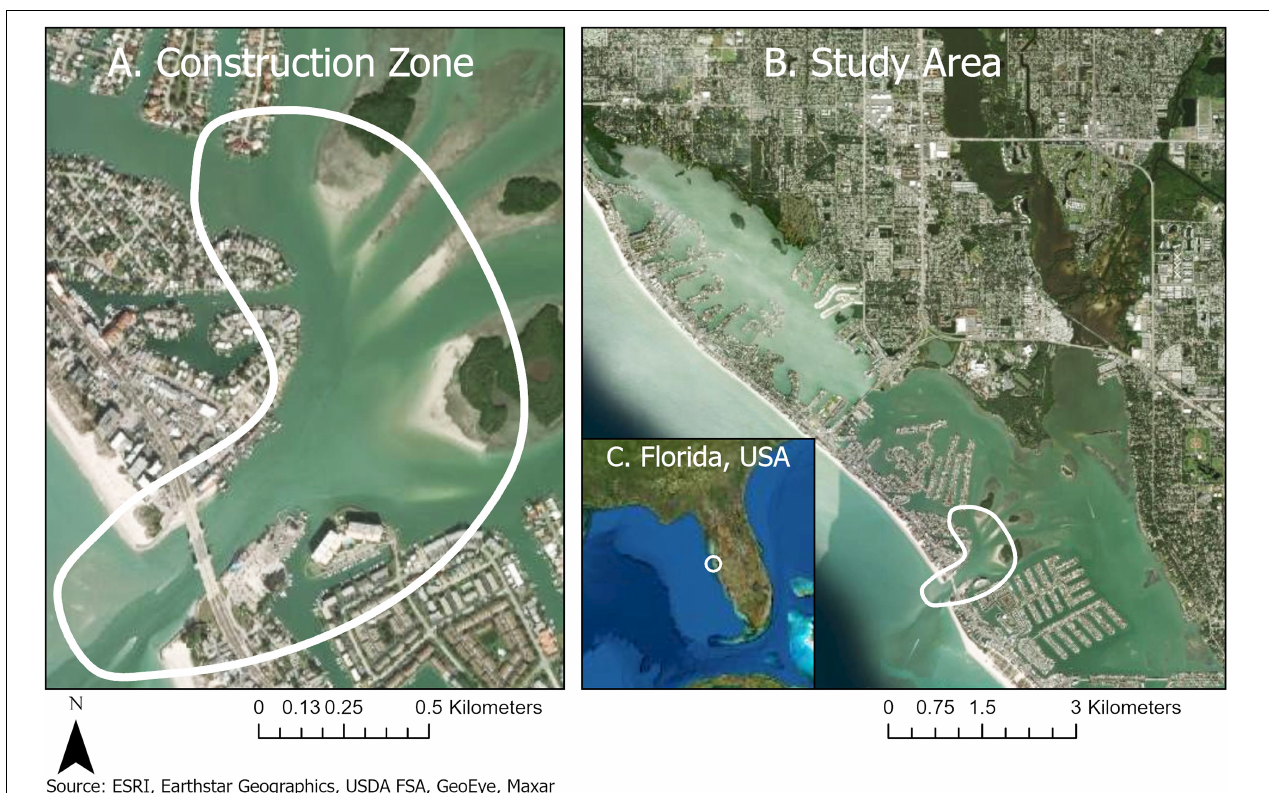
FIGURE 1 | A coastal construction project to replace a double-leaf bascule bridge exposed prime bottlenose dolphin feeding and socializing habitat to 58 months of noise pollution and habitat degradation. (A) John’s Pass construction zone (27.782679 ◦ , –82.782705 ◦ ). (B) Entire study area in the Intracoastal Waterway or ICW (north end: 27.831986 ◦ –82.830557 ◦ , south end: 27.771542 ◦ –82.753089 ◦ ) from Redington Shores to Treasure Island, Pinellas Country, Florida. (C) State of Florida. John’s Pass dolphins are part of the Tampa Bay, Florida